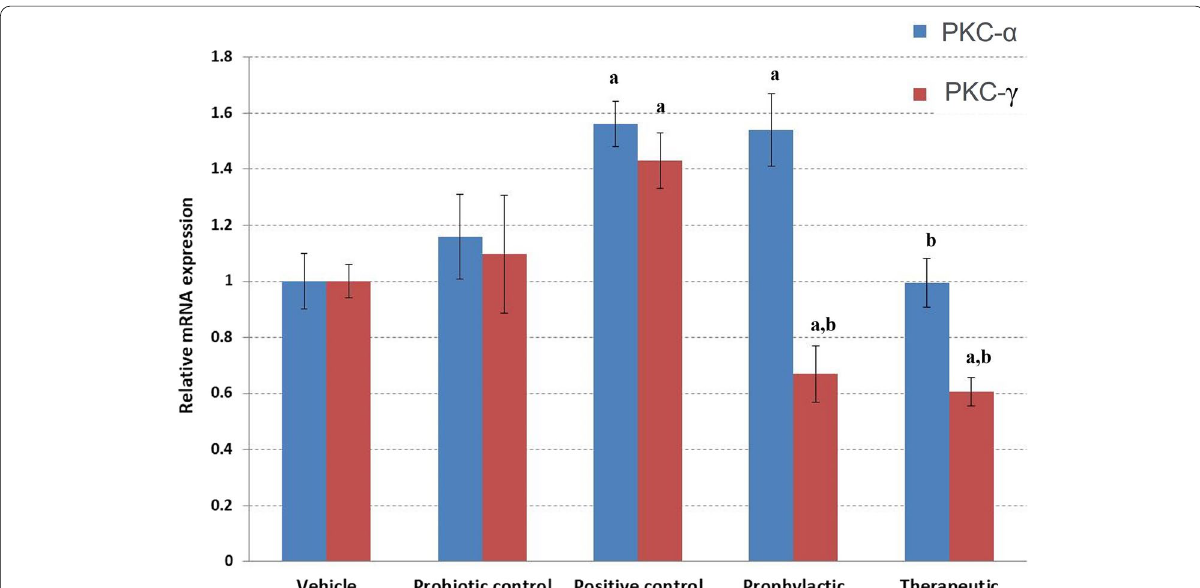
Fig. 5 Relative expression of protein kinase C‑alpha and ‑gamma in the liver of groups that received APAP and/or administered probiotic LGG. Expression values of PKC‑alpha or gamma from RT‑PCR were normalized to β‑actin. Relative expression was calculated using the comparative 2 − ΔΔCt method. a Significant p < 0.05 compared to the vehicle group. b Significant p < 0.05 compared to positive